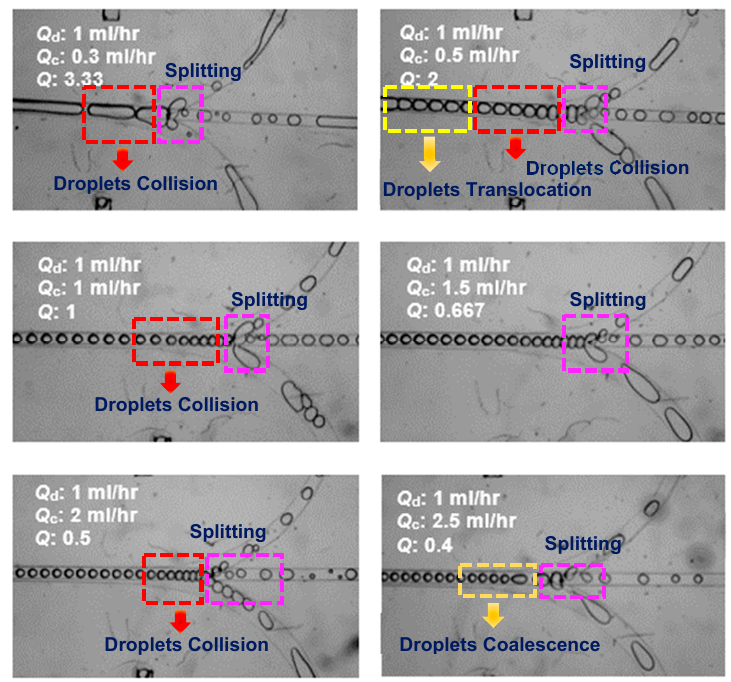
Figure 16. Droplet collision and coalescence phenomena in asymmetrical splitting junctions at different flow rate ratio (0.4 < Q < 3.33) by fixing the Q d and varying the Q c .